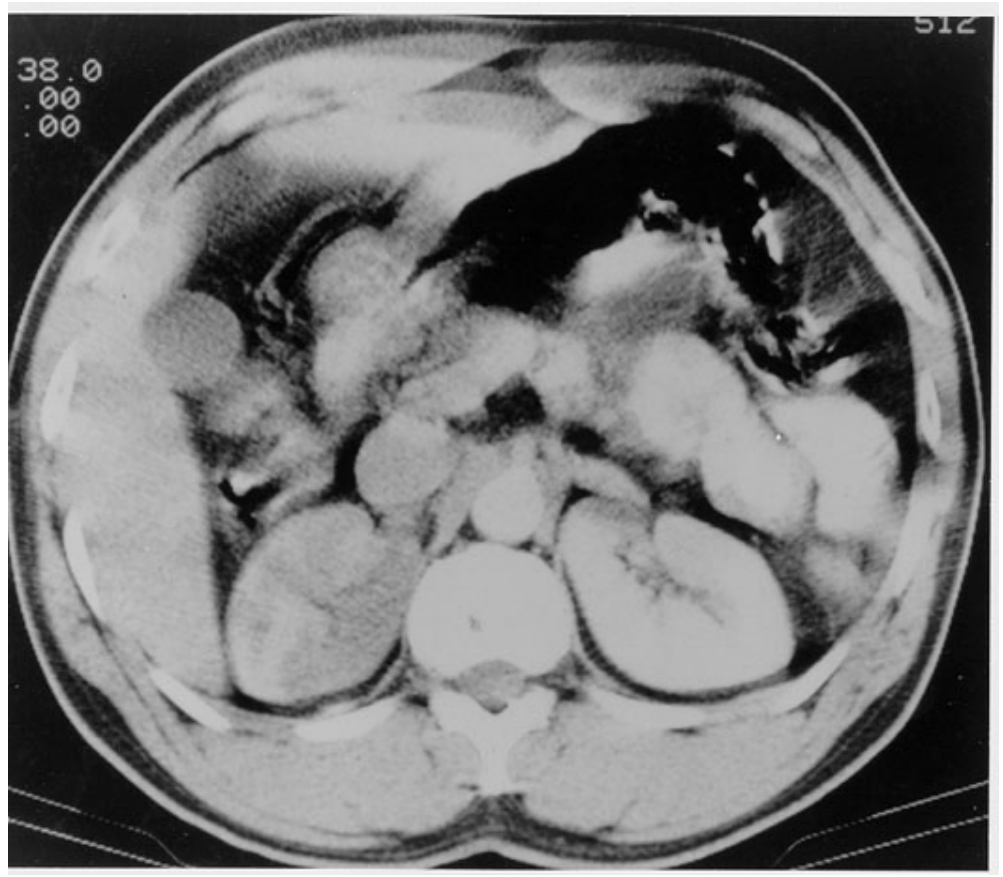
FIGURE 1. CT Scan of abdomen with intravenous and oral